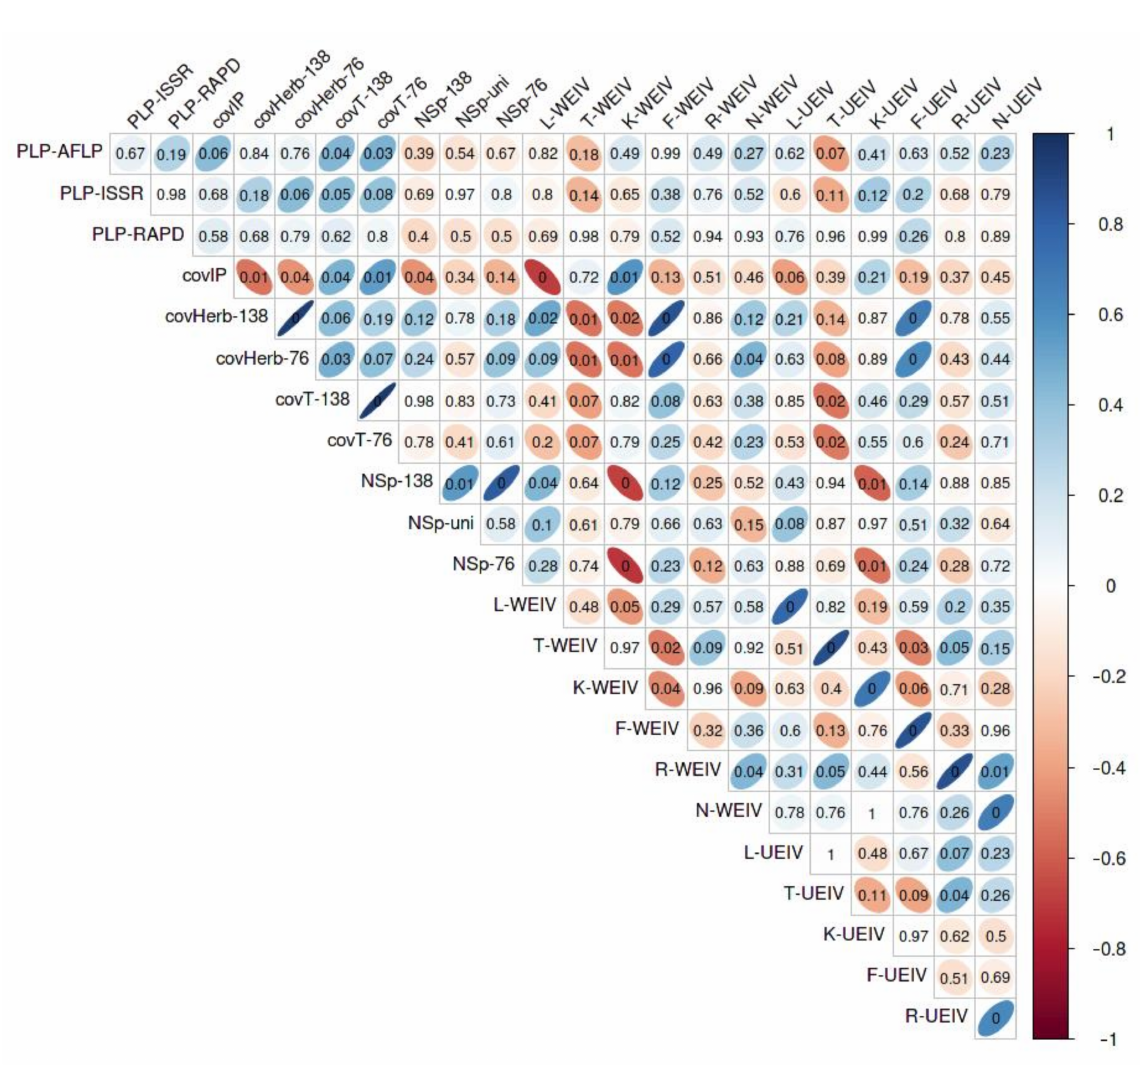
Figure 8. Spearman correlation coefficients (Rs) interrelating molecular, biotic, and abiotic variables of sites with small balsam ( Impatiens parviflora ). Color of the round figures reflects direction of correlation, numbers inside figures are values of significance, PLPs—are polymorphisms at AFLP (amplified frag- ment length polymorphism), ISSR (inter simple sequence repeats), and RAPD (randomly amplified polymorphic DNA) loci, covT— coverage by all herbaceous plant species, covHerb—by all herba- ceous plant species but I. parviflora ), covIP — coverage by I. parviflora ), NSp — number herbaceous plant species with and without unique species in sites, 138 or 76, respectively, weighted or un- weighted (WEIV or UWEIV) values for light (L), temperature (T), continentally (K), soil moisture (F), soil reaction (R), and soil nutrients